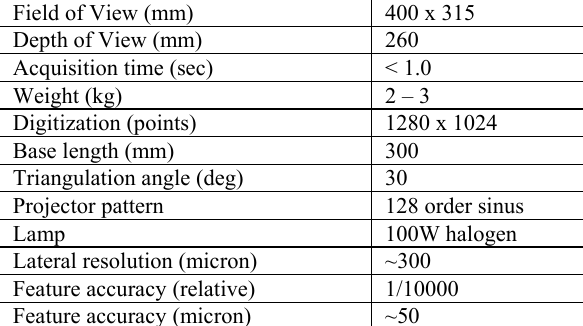
Table 1. Technical specifications of the optoTOP-SE